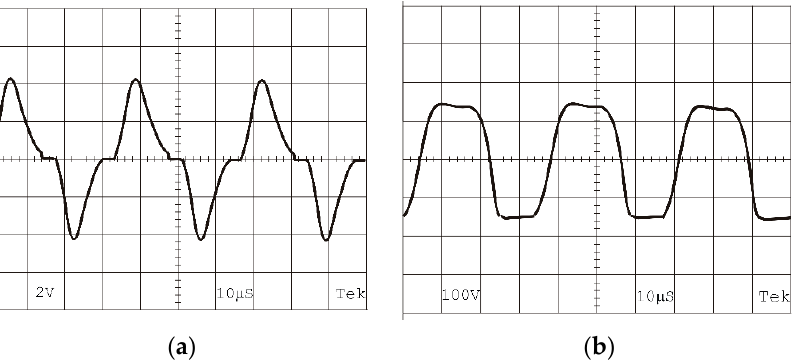
Figure 9. Graphical results obtained from the operation of the stand: ( a ) current through the resonant inductor (43.6 A maximum value) and ( b ) voltage on the resonant capacitor (maximum value 150